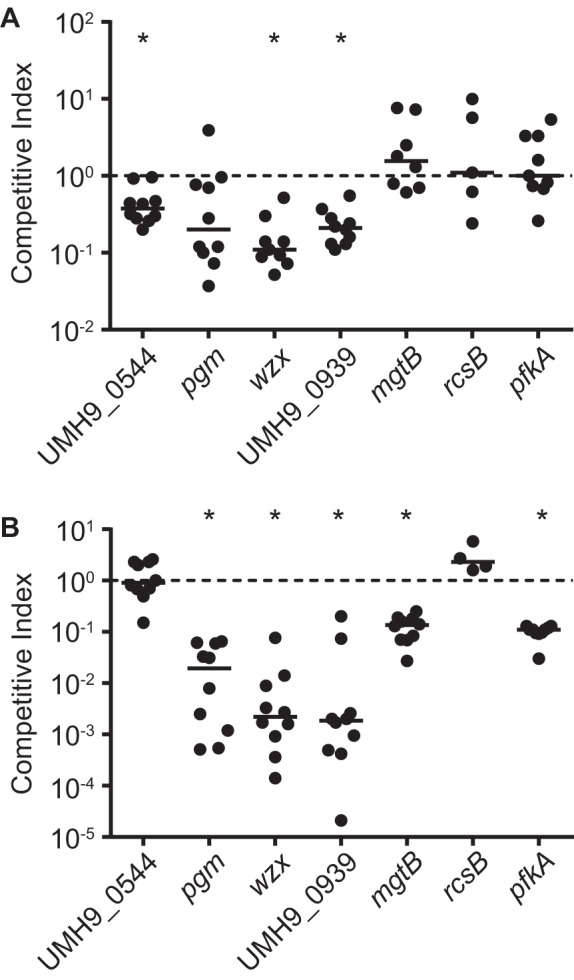
Validation of fitness gene mutants by competition infection. Mixtures (1:1) of the UMH9 parent strain and strains harboring mutations in the genes indicated were used to coinfect mice via tail vein injection. The numbers of viable bacteria present in the spleen (A) and kidneys (B) were determined and used to calculate the CI. A CI of 1.0 is indicated by the dotted line. Asterisks indicate mutants that exhibited a significant CI decrease from the hypothesized median value of 1.0 as determined by Wilcoxon signed-rank test (n = 10, P < 0.01).